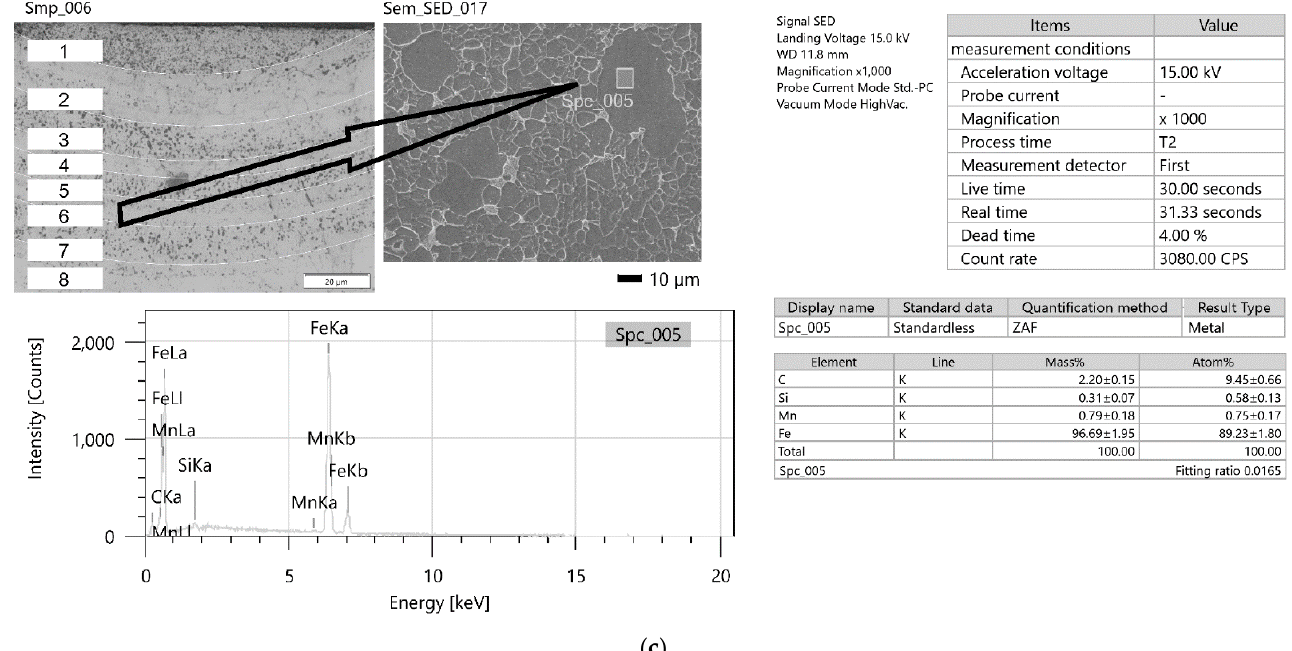
Figure 25. ( a ). Comprehensive report on the analysis of chemical composition for sample 3 from area 1 (Figure 24). ( b ). Comprehensive report on the analysis of chemical composition for sample 3 from area 2 (Figure 24). ( c ). Comprehensive report on the analysis of the chemical composition for sample no. 3 from area 6 (Figure 24).